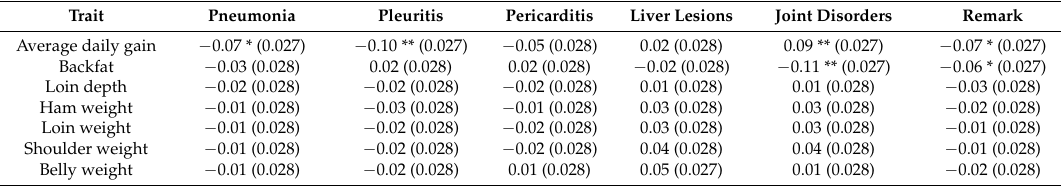
Table 5. Genetic correlations with finishing and carcass quality